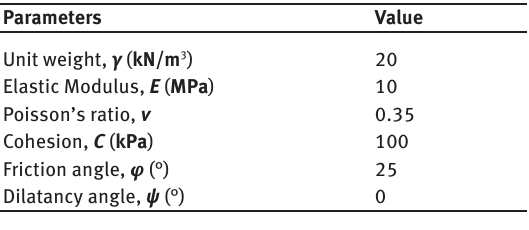
Table 2: Soils parameters used in the numerical study. Parameters Value